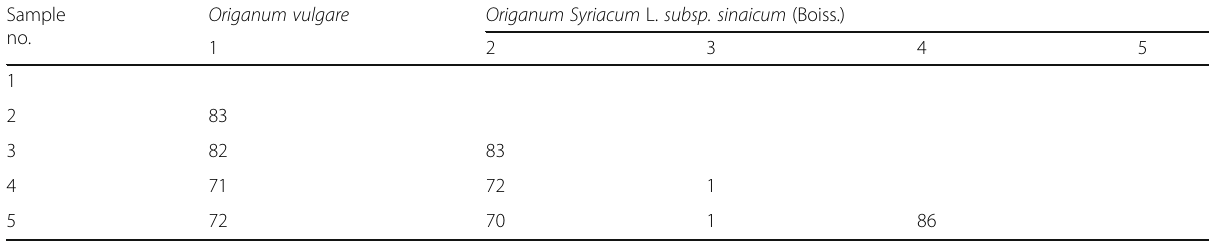
Table 6 Genetic similarity matrix within Origanum samples based on AFLP data Sample Origanum vulgare Origanum Syriacum L. subsp. sinaicum (Boiss.) no.